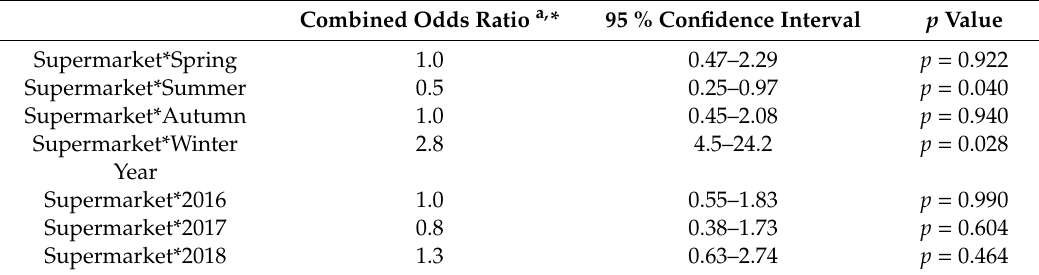
Table 4. Combined odds ratio analysis of Salmonella prevalence. Combined Odds Ratio a, * 95 % Confidence